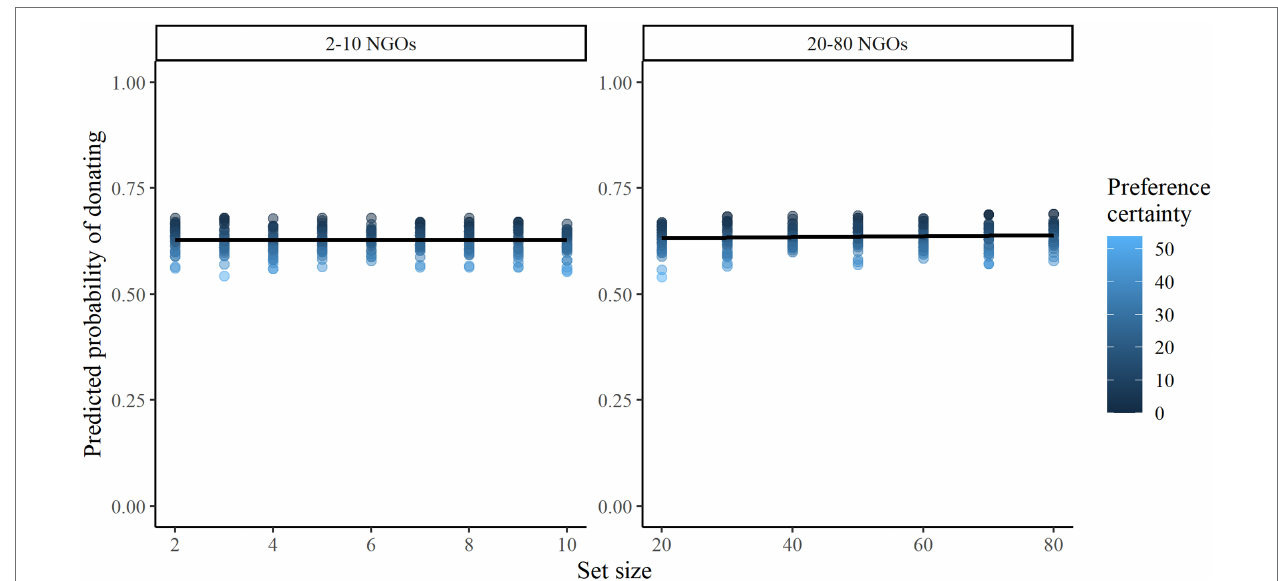
FIGURE 2 | Predicted probability of donating by organization set size. Individual points are colored by preference certainty score, with higher scores depicted as lighter points. Points illustrate predicted values for each participant based on the fitted model.